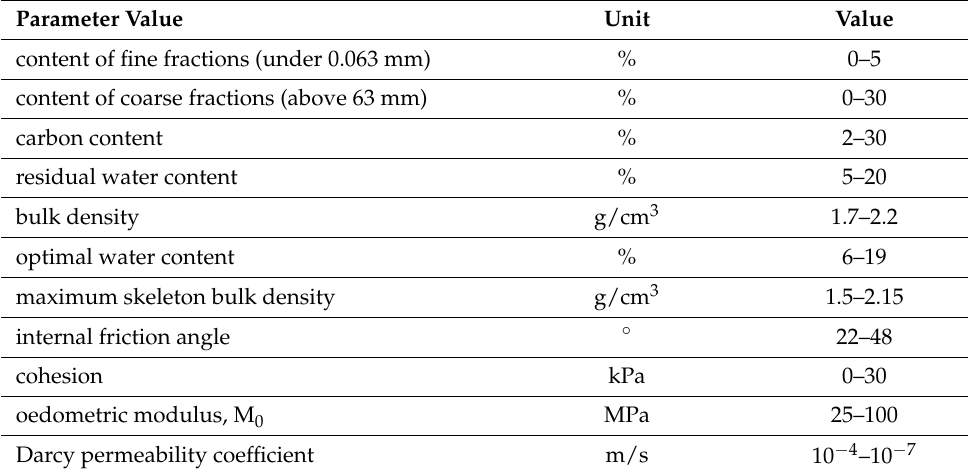
Figure 6. Results of dynamic sounding through the dump mass [18]. Table 1. Parameters Characterising Waste from the Mining Industry